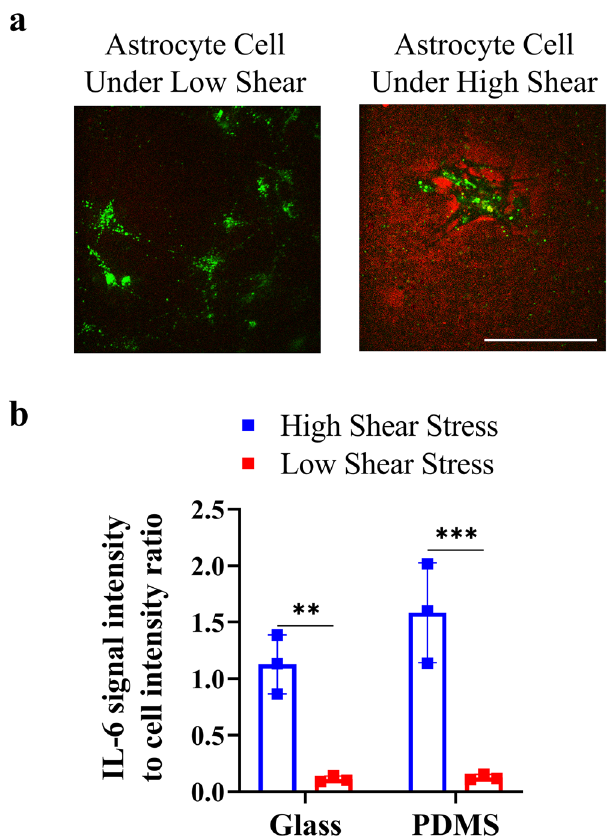
Fig. 5 ELISpot population analysis of astrocyte under low and high shear stress on different substrates. a Representative fl uorescence image for glass substrate qualitatively depicting IL-6 signal (red) distribution merged with astrocyte signal (green), and b IL-6 signal intensity to cell signal intensity ratio. After shear-cytokine activation of astrocyte, astrocytes were stained with DiO lipophilic membrane labeling dyes. Each data point denotes an average value for n = 5 cells measured. Intensity values were normalized for the number of cells present. Independent experiments were performed on three different devices ( n = 3) per substrate. The results are represented as mean ± SD in the plots. Scale bar represents 100 µ m. The p values ** and *** denote p = 0.0056 and p =